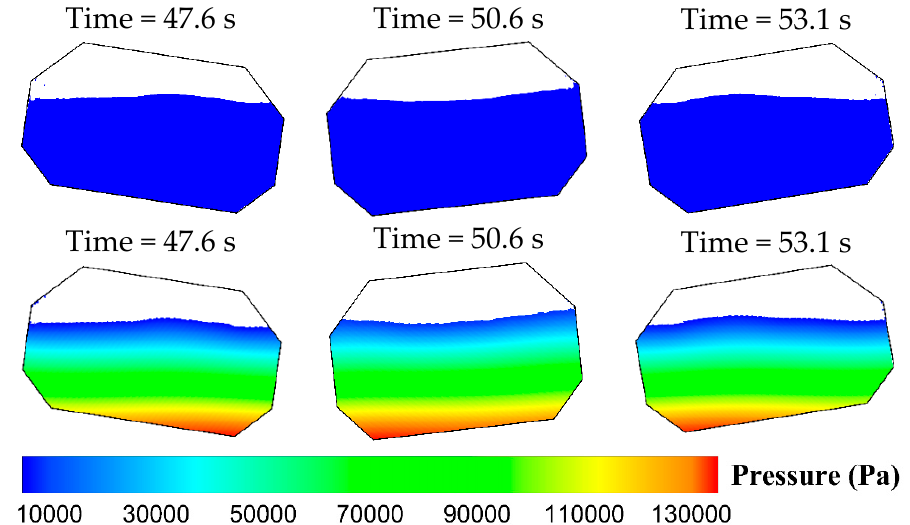
Figure 12. Snapshots of free surfaces ( first line ) and corresponding pressures ( second line ) in the case T = 11.0 s at various moments.